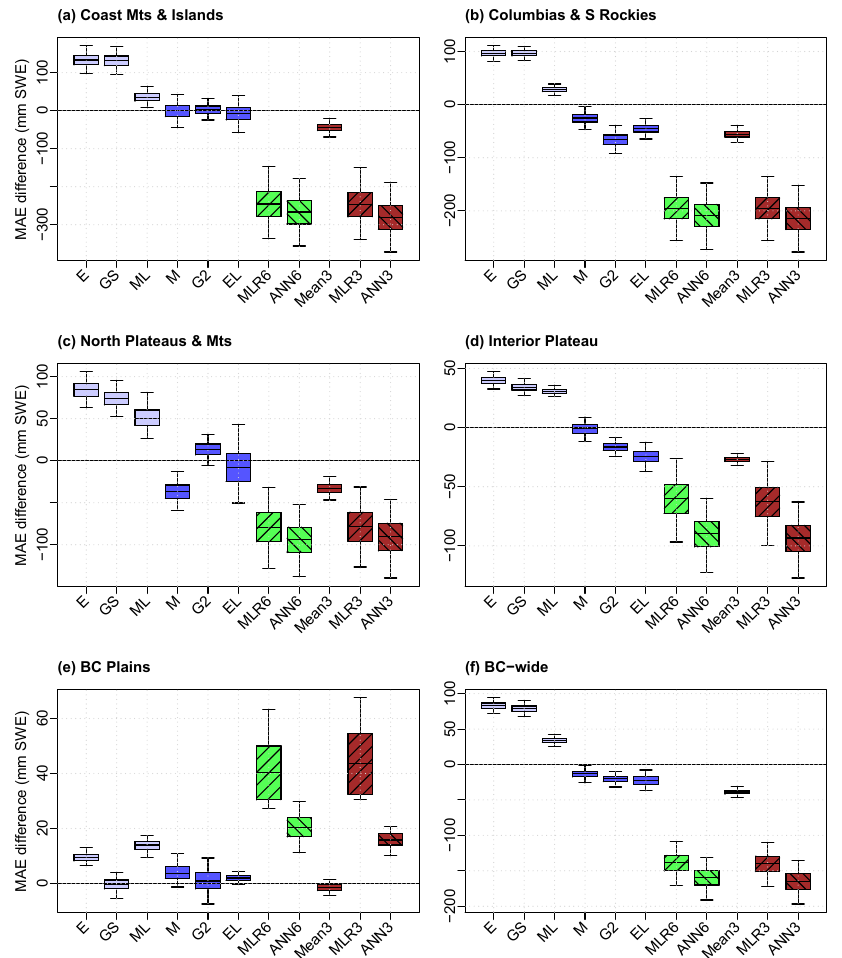
Figure 6. Bootstrap mean station MAE differences between several SWE products/combinations and the reference (the mean of six products). First quartile, median, and third quartile are plotted respectively as the bottom, waist, and top of each box, and 95% confidence intervals are indicated by whiskers. MAE difference spreads are shown for regions of BC in order of descending mean accumulations: (a) Coast Mountains and Islands, (b) Columbia Mountains and Southern Rockies, (c) Northern Plateaus and Mountains, (d) Interior Plateau, (e) BC Plains, and (f) province-wide. Product and combination abbreviations and colors are as in Fig. 4. Note differences in vertical